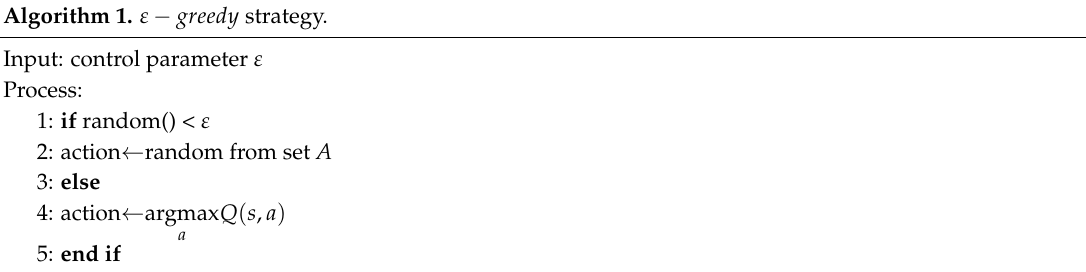
Algorithm 1. ε − greedy strategy.